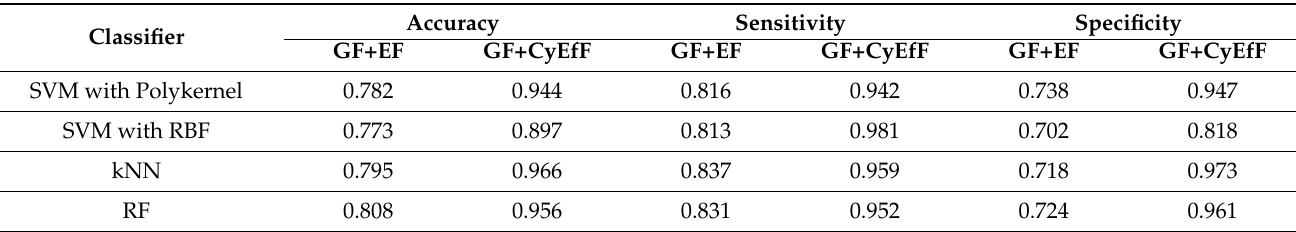
Table 2. Classification results of four classifiers using combination of feature